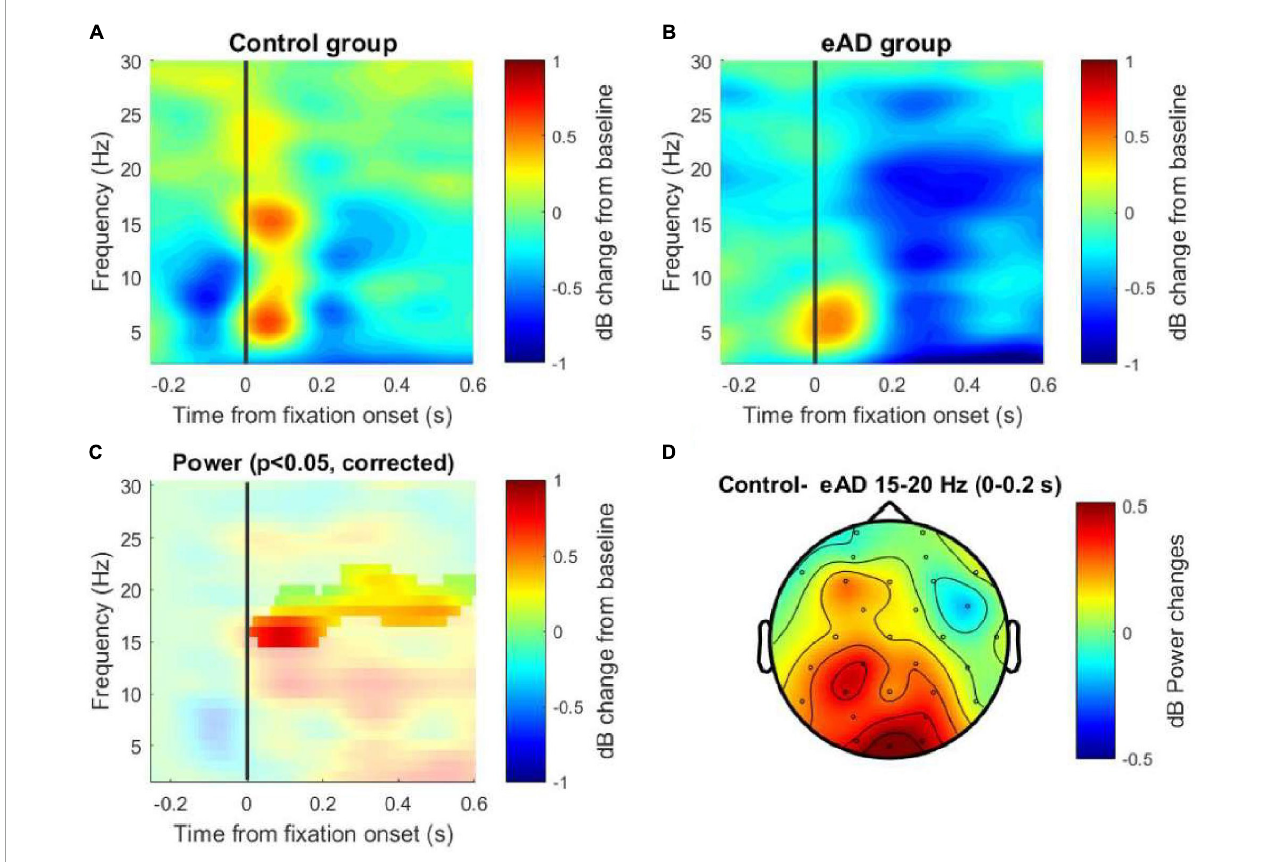
FIGURE4 Time-frequency (TF) maps of the Oz channel. (A) Power spectral decomposition of the electroencephalography (EEG) data for the control group and (B) for the early Alzheimer’s disease (eAD) group. (C) Cluster-based permutation test on TF activity of the Oz channel. The analysis considered 1,000 permutations to determine the cut-off alpha = 0.025, to two tails, resulting in significant differences in the beta band between 15 and 20 Hz. (D) Topographical map from the differences in power data averaged. The solid line (vertical line) represents the zero time at the beginning of the eye fixation. The color scale represents the percentage of change relative to the baseline period of –750 to –450 ms and normalized in